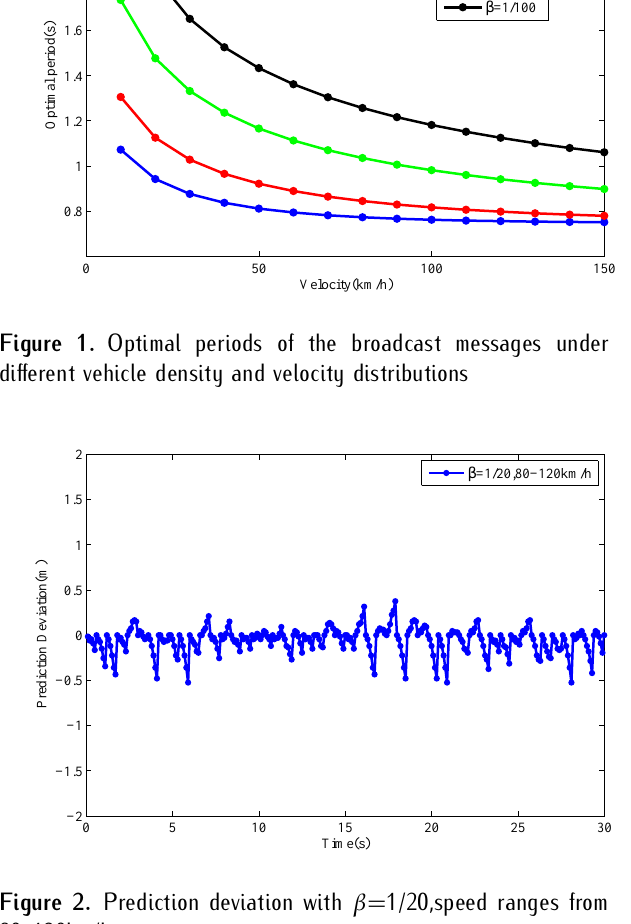
Figure 2. Prediction deviation with β =1/20,speed ranges from